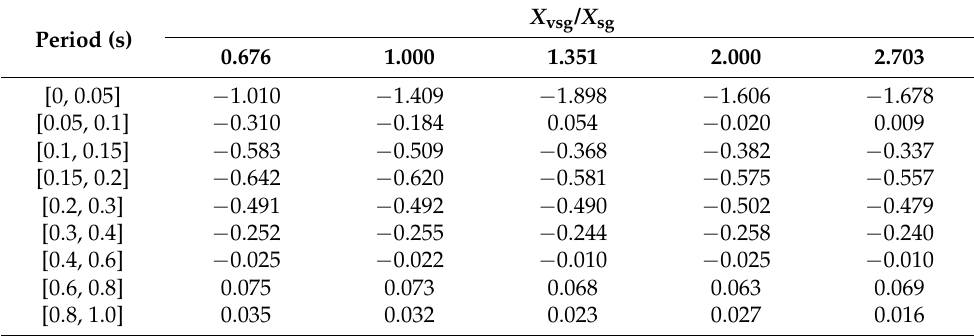
Table A6. RoCoF (Hz/s) ( X vsg was changed).